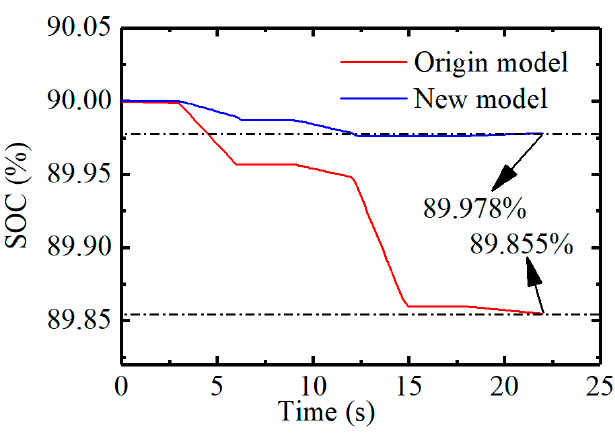
Figure 10. Economic verification results: SOC change.